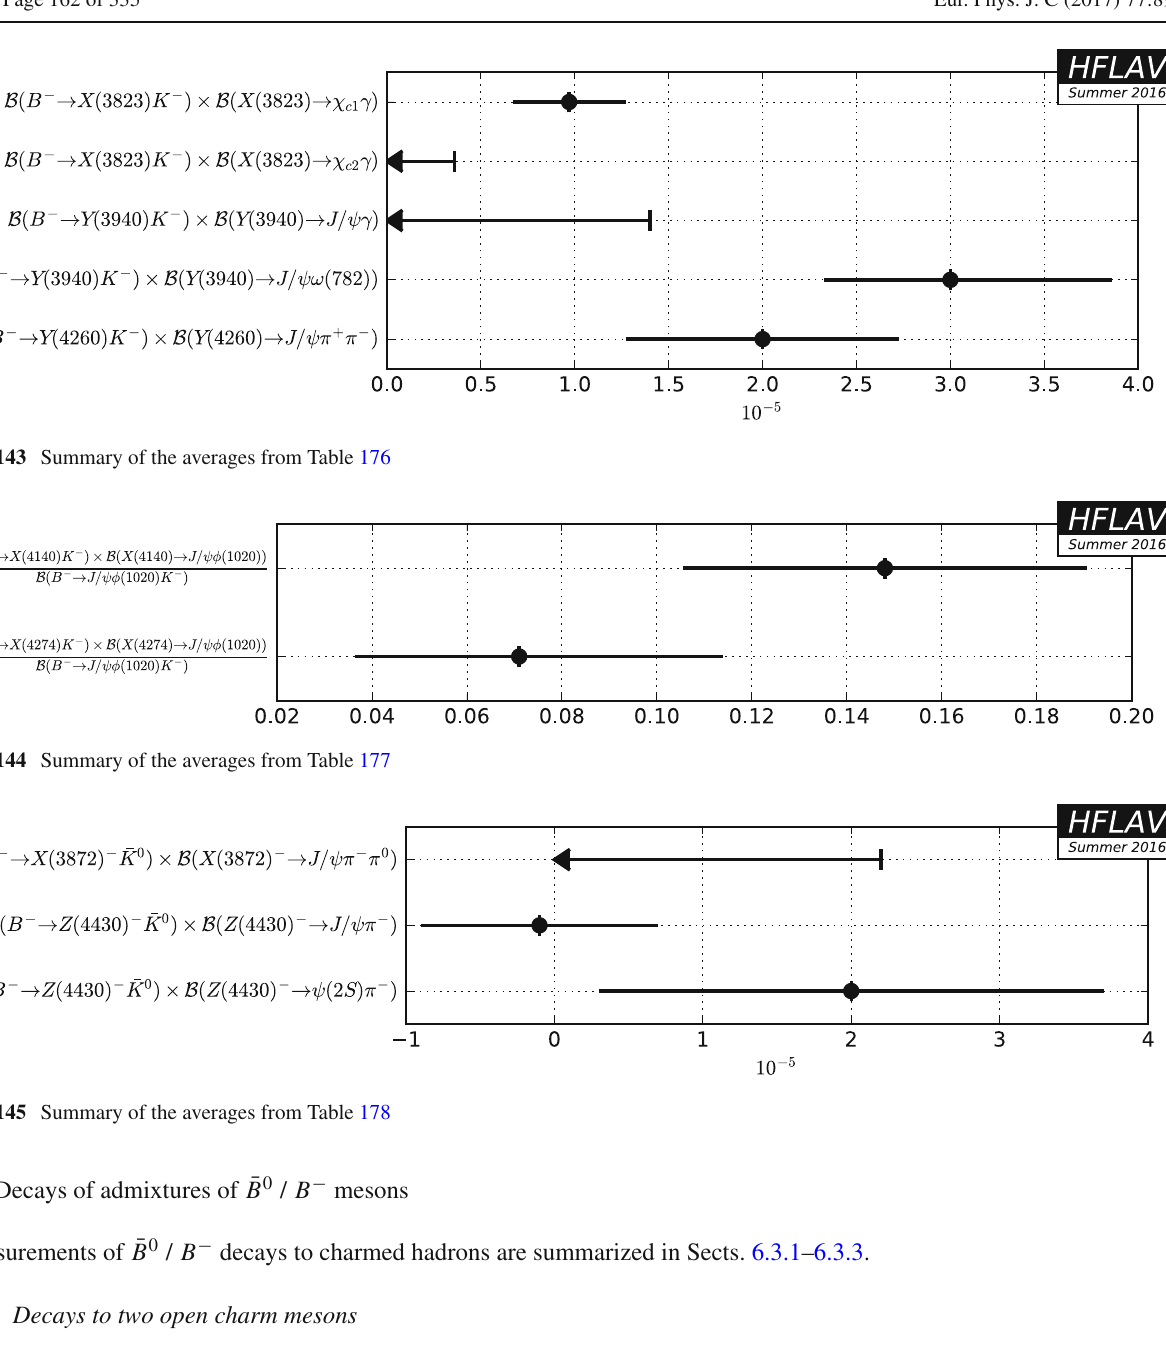
¯ B 0 / B − decays to two open charm mesons are shown in Table 179. Averages of